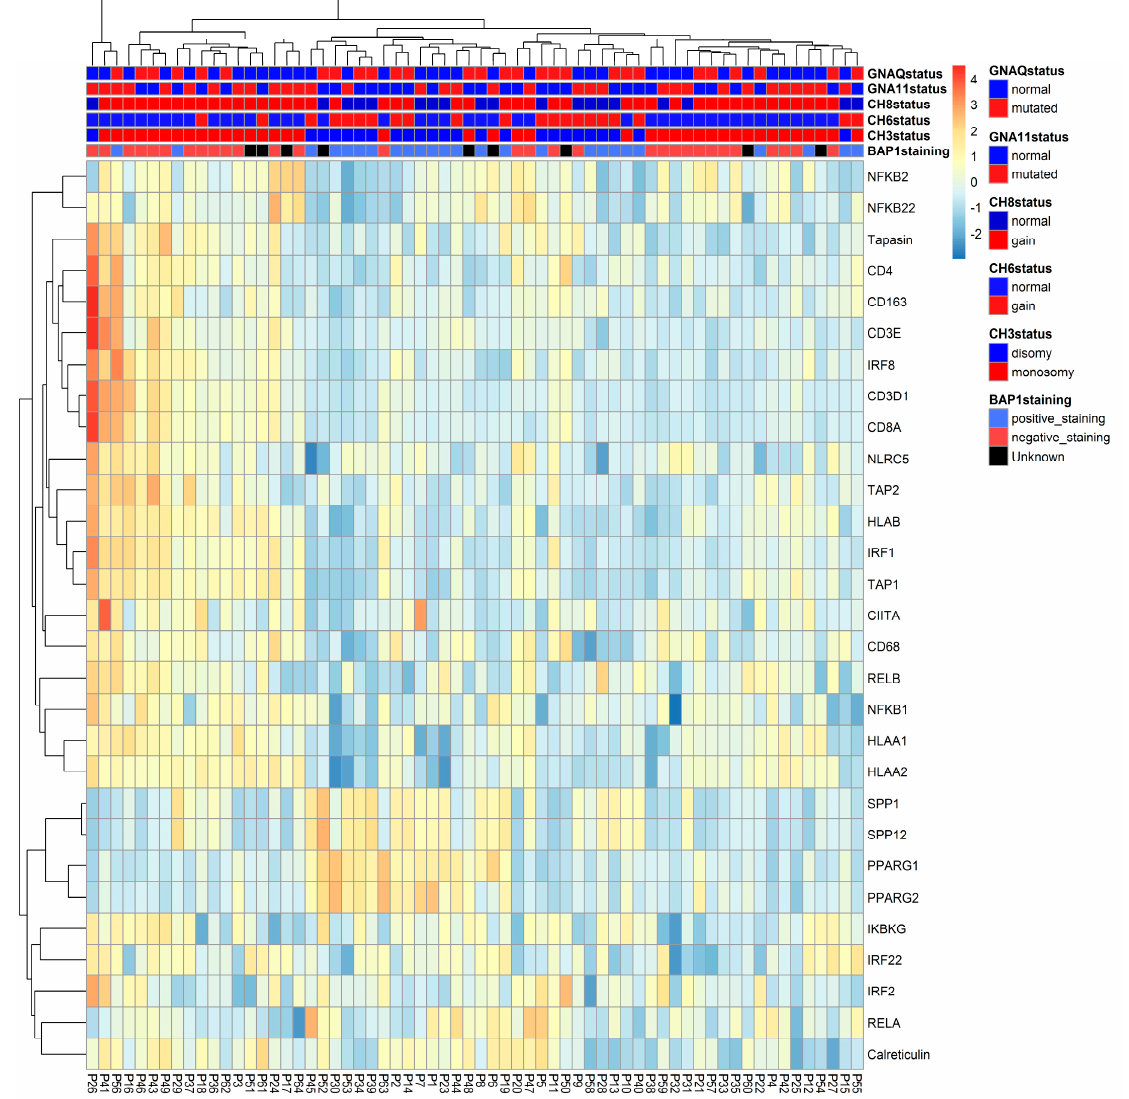
Figure 1. Heat map of 64 UM, highlighting mRNA expression levels of inflammatory markers. The presence of BAP1 staining, the status of chromosome 3, 6p and 8q, and the presence of GNAQ and GNA11 mutations are also shown. Clusters were created by unsupervised clustering of the tumors.